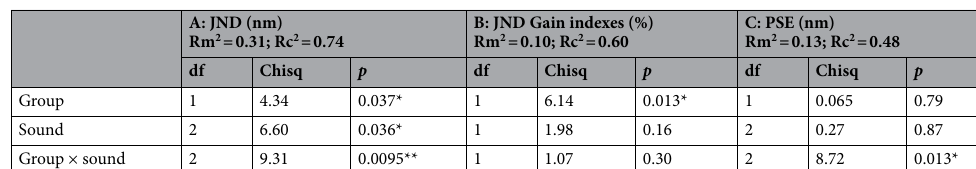
Table 1. Summary of the statistical results from the generalized linear mixed models for the JND (A) and PSE (B) variables and the general linear mixed model for the Gain indexes variable (C). Marginal ( Rm 2 ) and conditional ( Rc 2 ) variances explained, degree of freedom (df), chi-square (Chisq) and p-value ( p ) are given.